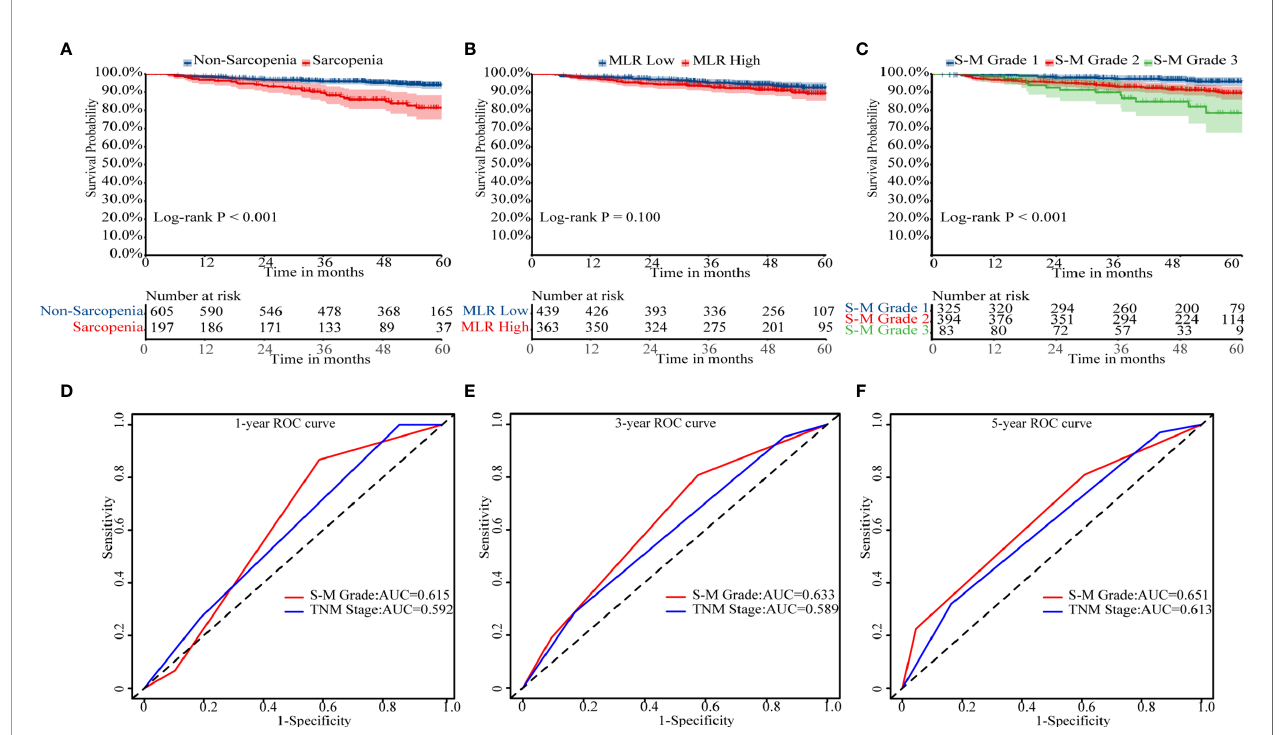
FIGURE 1 | Kaplan – Meier survival curves and receiver operating characteristic curve analysis. Kaplan – Meier curves for overall survival by (A) skeletal muscle index, (B) monocyte-to-lymphocyte ratio, and (C) combined skeletal muscle index and monocyte-lymphocyte ratio (S-M) grade. (D – F) Capacities of S-M grade and TNM stage to predict overall survival for 1, 3, and 5 years. S-M grade, combined skeletal muscle index and monocyte-lymphocyte ratio.